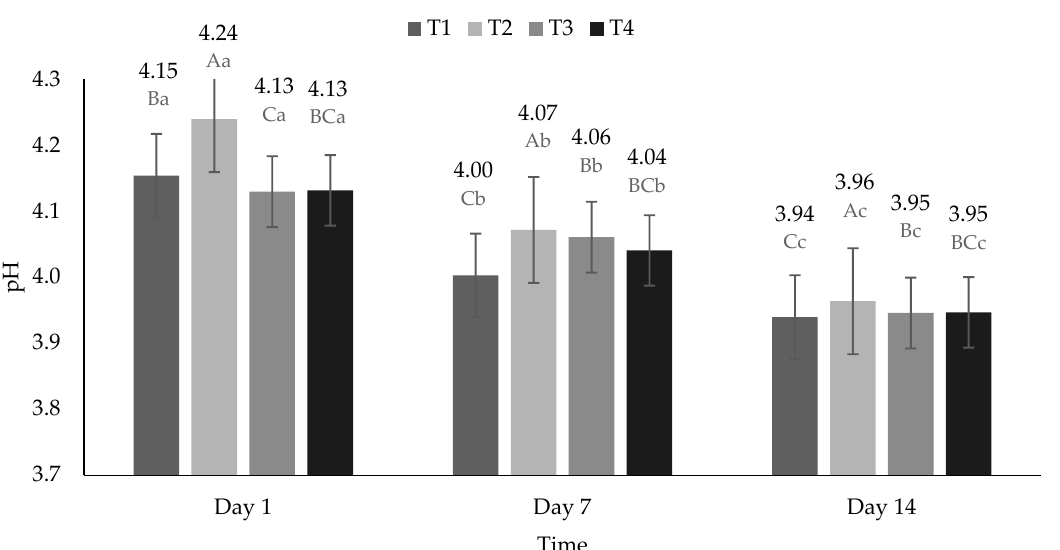
Figure 1. Hydrogen potential (pH) of yogurt added with beet extracts. T1 = Natural yogurt (Y), T2 = Y added with beet juice, T3 = Y added with extract encapsulated with Maltodextrin, and T4 = Y added with extract encapsulated with Inulin. A,B,C Values with different superscript indicate significant statistical difference between treatments ( p < 0.05). a,b,c Values with a different superscript indicate a statistically significant difference over time ( p < 0.05).